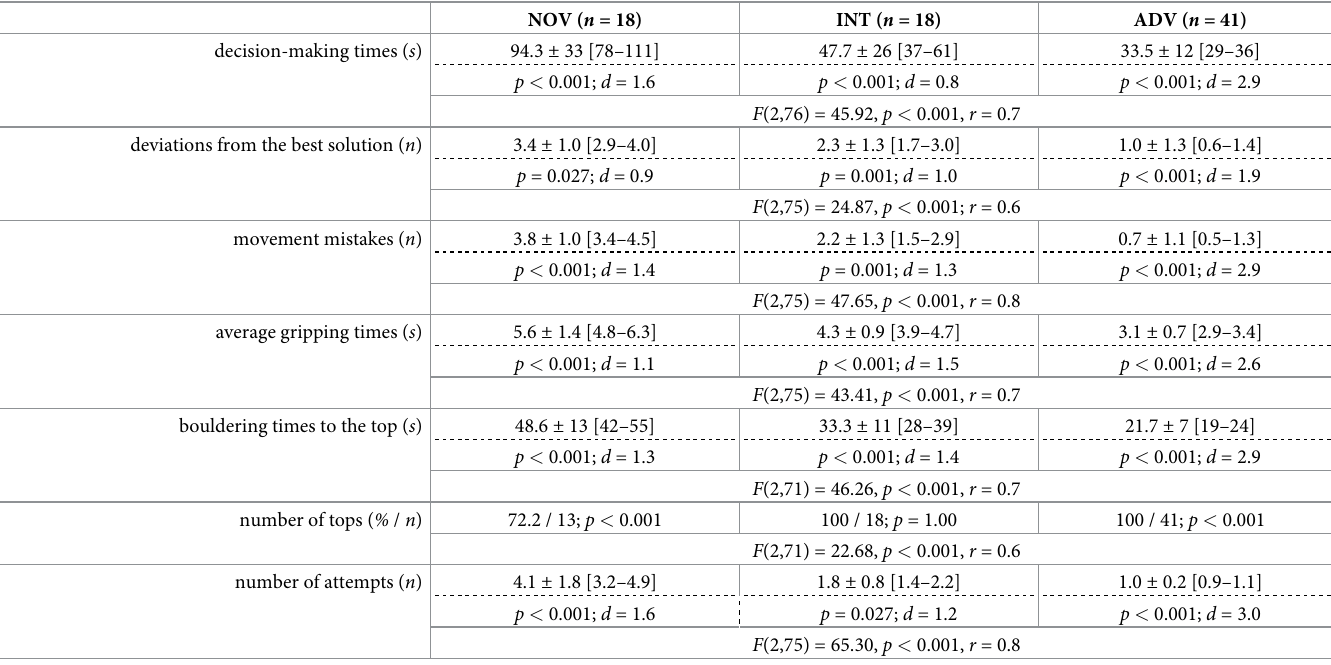
Table 2. Study results of the novice group (NOV), the intermediate group (INT), and the advanced group (ADV) in Experiment 1.